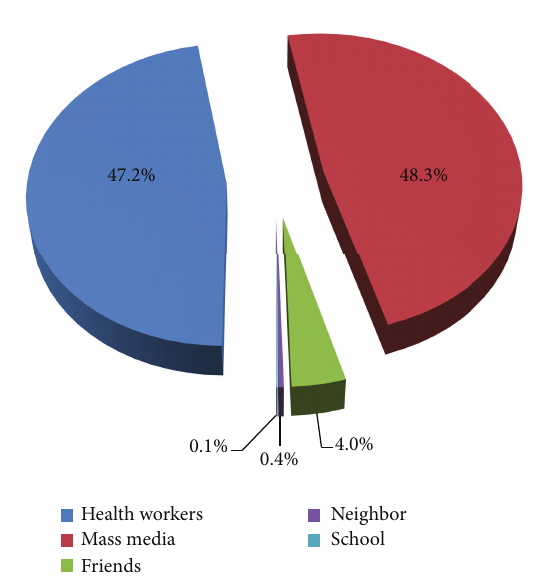
Figure 2: Sources of information for VCT, BDU, April